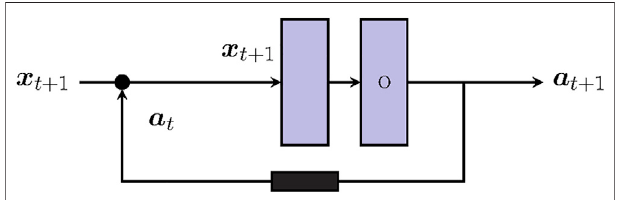
FIGURE 3 | One-dimensional hyperelastic rheological model (A) and example load cycle (B)